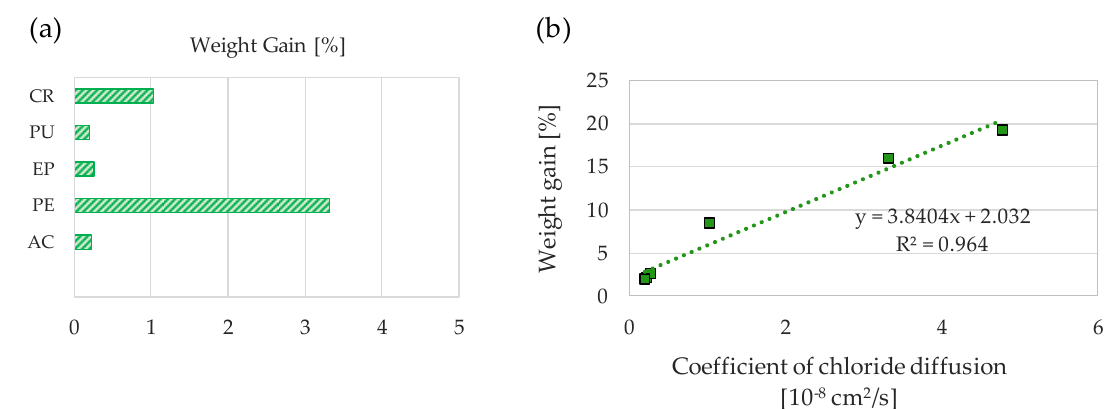
Figure 20. ( a ) Weight gain of uncoated and coated cement mortar specimens after 56 h of immersion in water and ( b ) correlation between weight gain and chloride penetration [28]. CR, chlorinated rubber; PU, polyurethane coating; EP, epoxy coated specimens; PE, polymer emulsion coatings; AC, acrylic coatings.